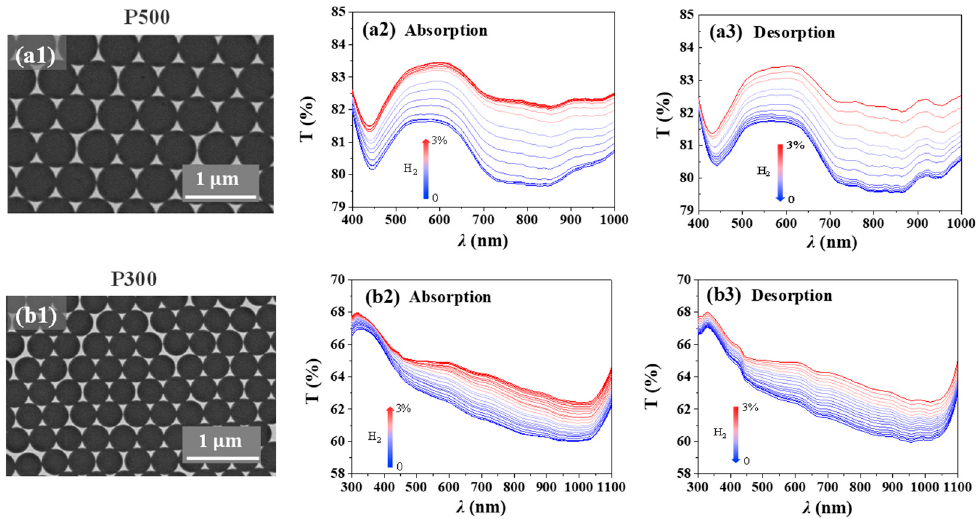
Figure 4. Optical transmission spectra of Pd NTAs during hydrogen absorption and desorption processes (( a1 – a3 ) are the SEM morphology and transmission results of P500; ( b1 – b3 ) are the SEM morphology and transmission results of P300).